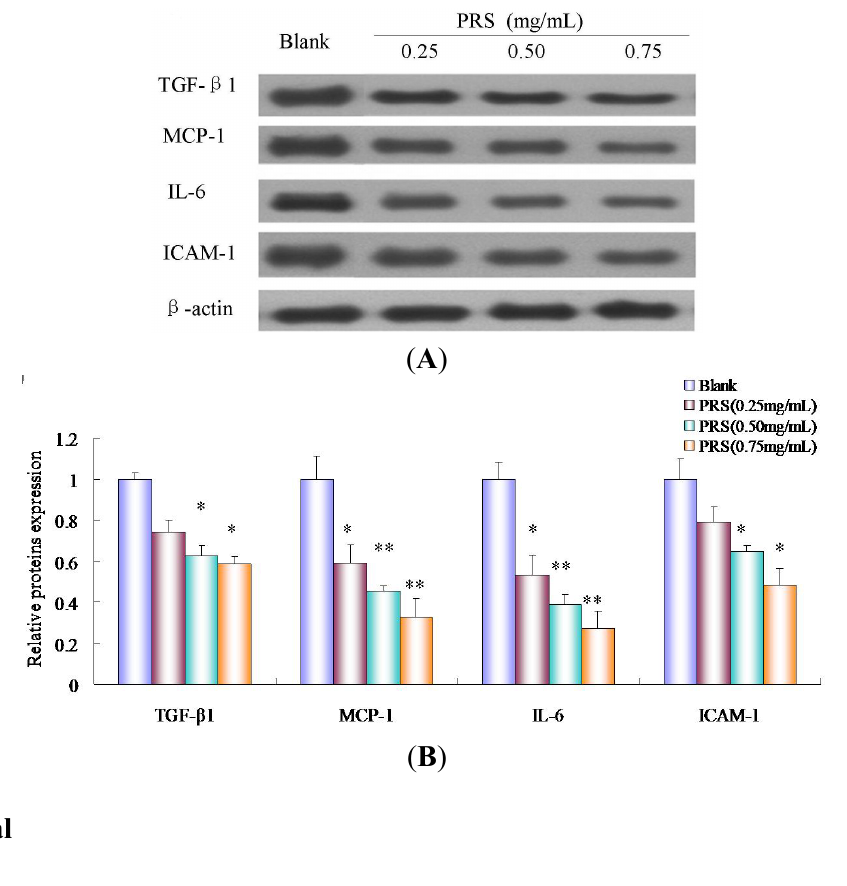
Figure 9. Effect of PRS on the expressions of inflammation-related proteins by Western blotting. A549 cells were incubated in the presence and absence of PRS (0.25, 0.50 and 0.75 mg/mL) for 24 h. Cells were homogenized, lysed, 50 μ g of protein samples were submitted to 10% SDS-PAGE and electroblotted. Enhanced chemiluminescence system was used for visualization ( A ) and protein expression was quantified by IPP software. Results are expressed as the ratio of the band volume of PRS to that of blank. The data are expressed as means ± SD ( n = 6). * p < 0.05; ** p < 0.01, vs .